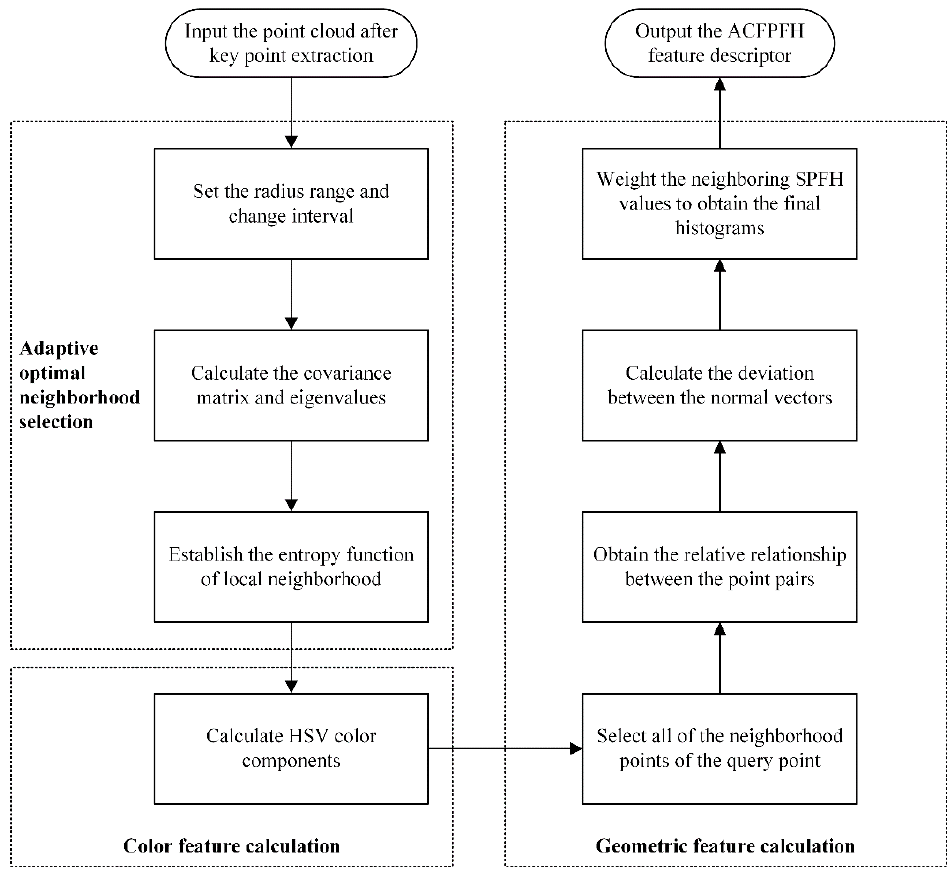
Figure 3. The flowchart of the feature description.